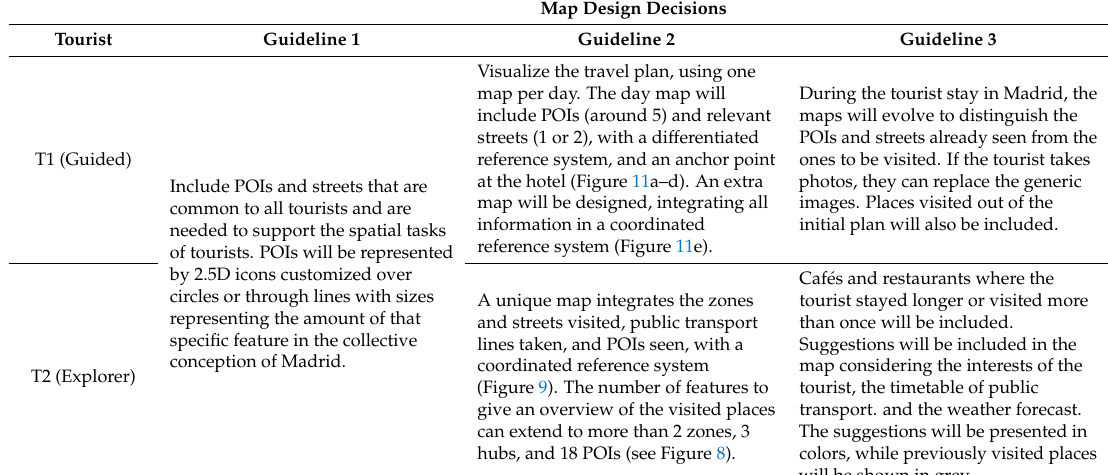
Table 3. Map design guidelines for tourists T1 and T2.